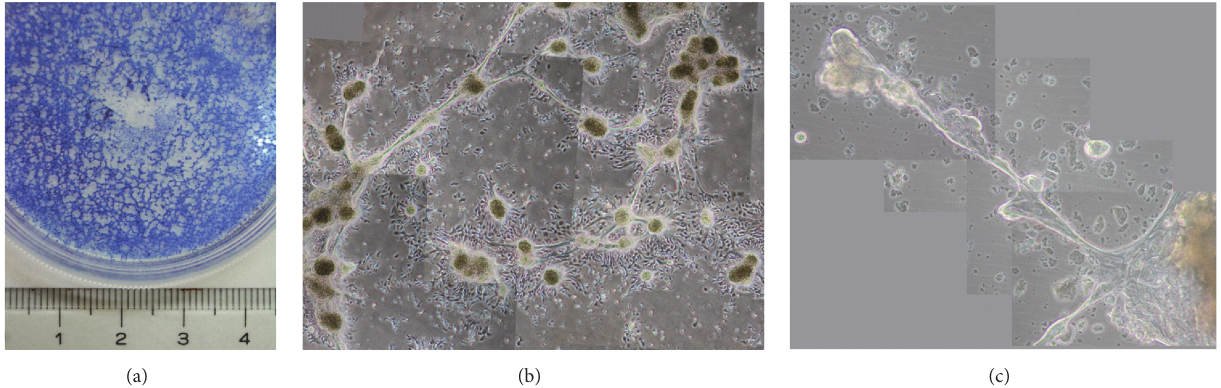
Figure 7: Two types of HBECs (Type I HBECs developed in the K-NAC medium and Type II HBECs in 1:2 ratio) were inoculated in a poly-D-lysine coated plate. (a, b) After plating for 14 days, these cells formed mammary organoids. (c) After incubation for 28 days, these organoids were found to develop many mammary ductal and terminal end bud-like